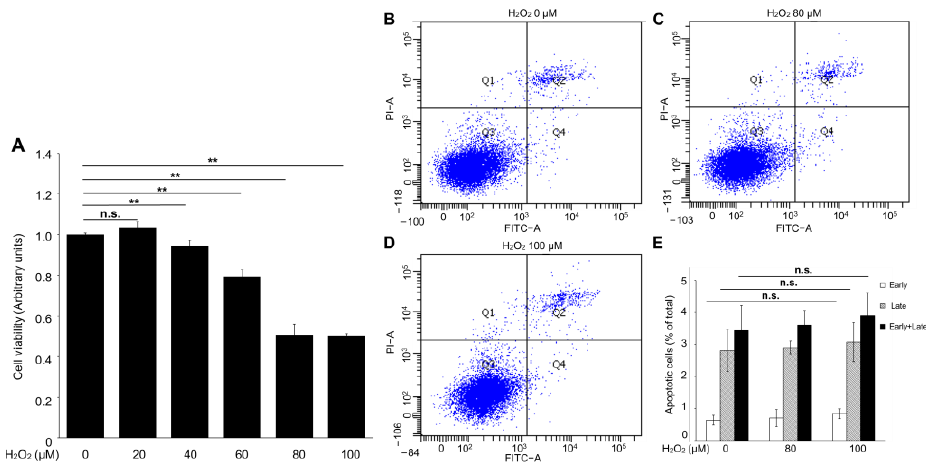
Figure 2. The apoptotic effect of hydrogen peroxide on ARPE-19 cells. ( A ) Cell-viability assay. ( B – E ) Representative flow-cytometer dot plot of apoptosis in ARPE-19 cells. n = 6 in each group, n.s. denotes not significant. ** p < 0.01